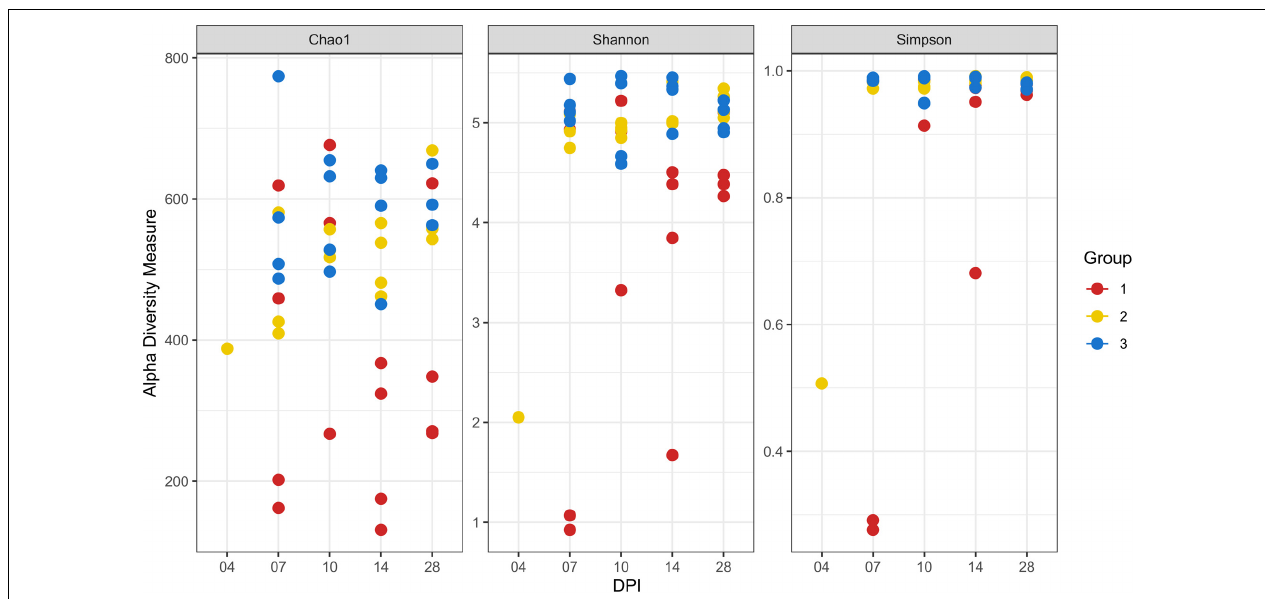
FIGURE 4 | Alpha diversity analyses in cecal samples. Each dot corresponds to one sample. Group 1, infected with H. meleagridis + lux -tagged E. coli ; Group 2, infected with lux -tagged E. coli ; Group 3, negative control. dpi denotes for days post H. meleagridis